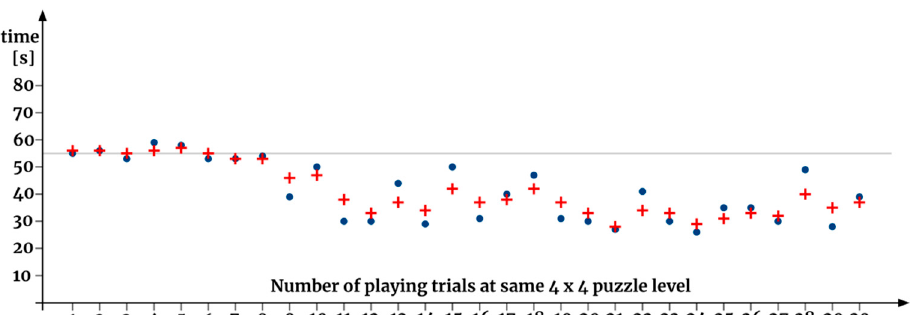
Figure 5. Adaptation of time frame according to level completion time for player type 3. Blue dots represent the level completion time; red crosses represent time frames adapted to the player.